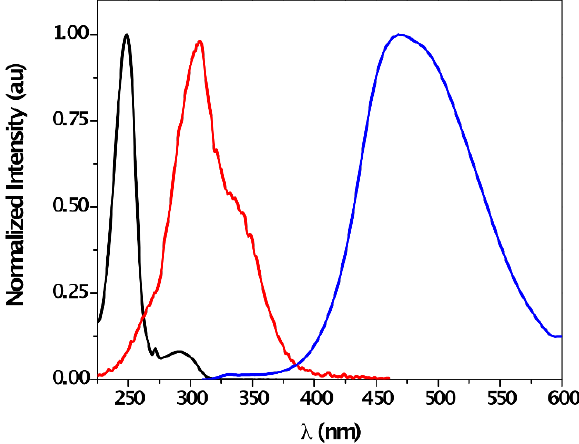
Figure 5. Normalized absorption band of 1 (black line, left ), excitation (red line, centered , λ em = 468 nm) and emission (blue line, right , λ exc = 320 nm) spectra of a mixture of 1 ( c = 0.04 mM) and F¯ ( c = 2 mM) in acetonitrile under aerobic conditions.